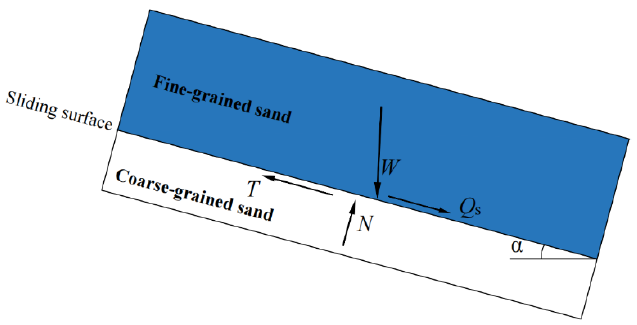
Figure 6. Forces at the interface of fine/coarse-grained soil layers.